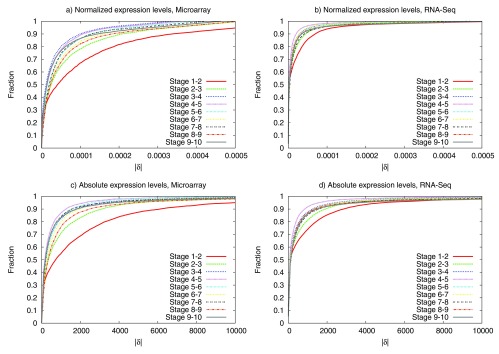

Drosophila data: CDFs of the expression level absolute variations |
δ| across successive stage-pairs.(
a) normalized expressions, Microarray, (
b) normalized expressions, RNA-Seq, (
c) absolute expressions, Microarray, absolute expressions, RNA-Seq. [Dataset 12].